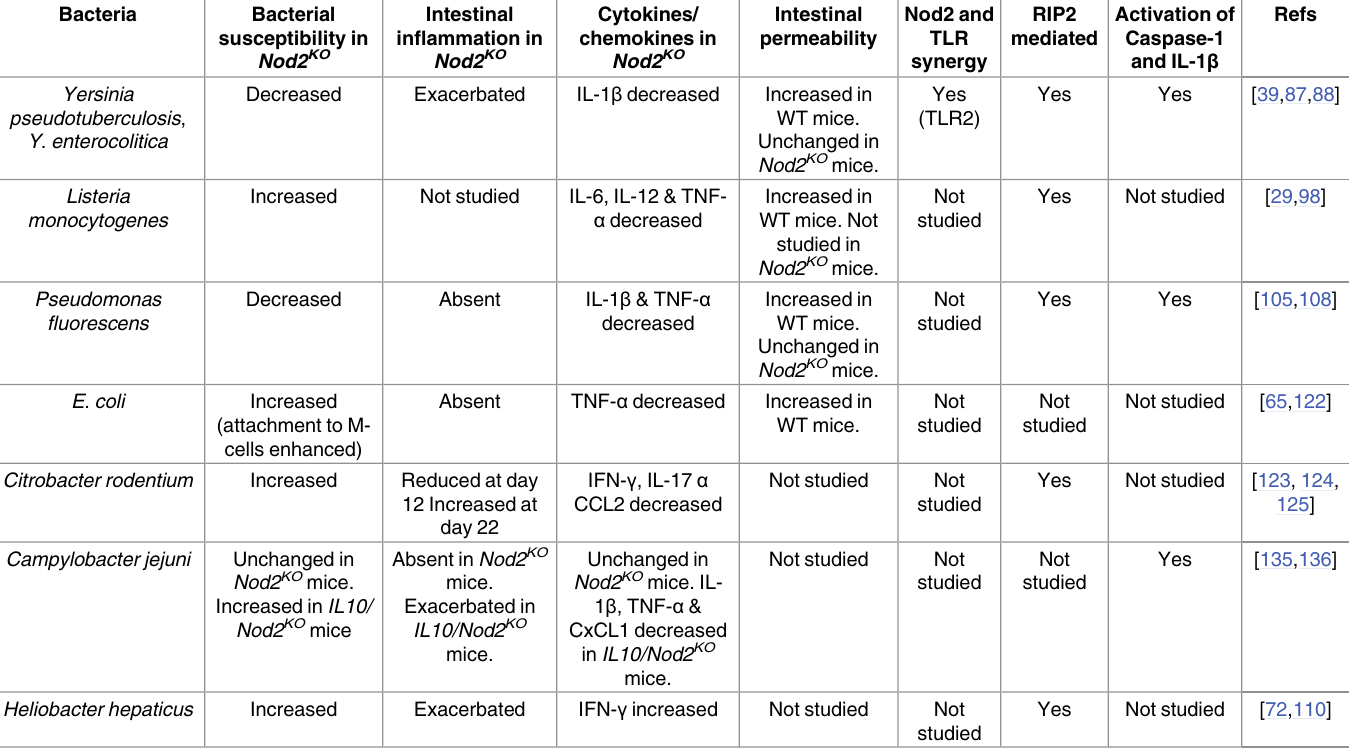
Table 1. Role of Nod2 in the host response toward pathogenic